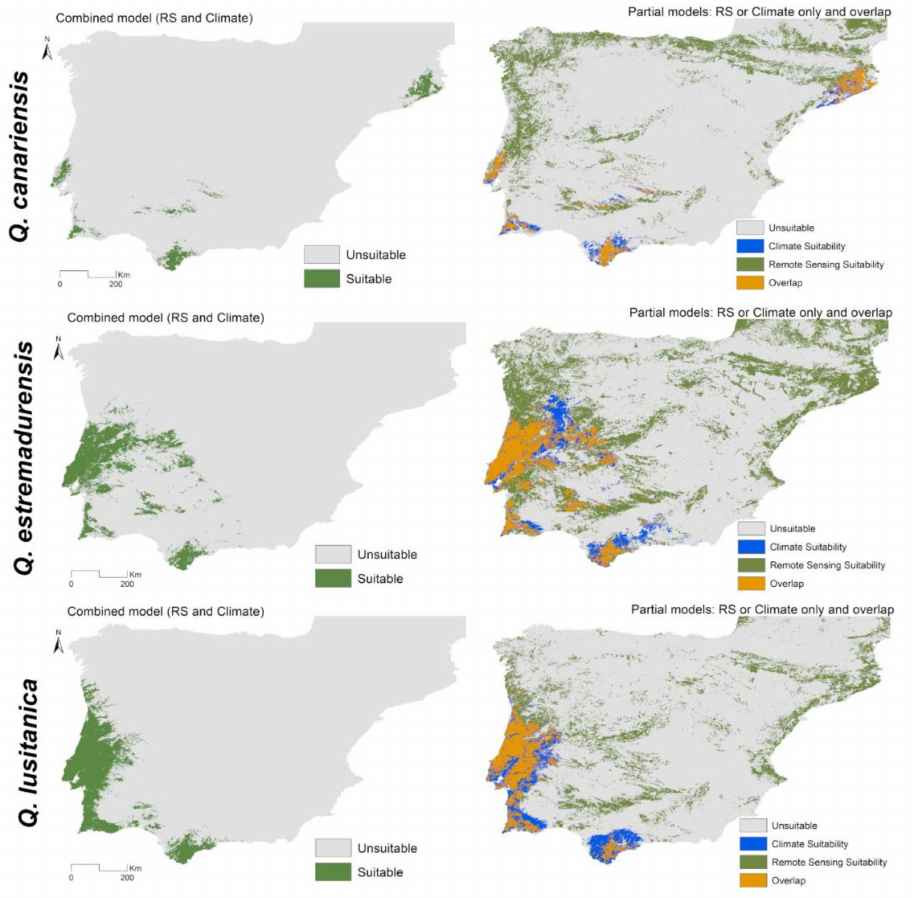
Figure 5. (Left) Combined models (remote sensing EFA—and climate) and (right) partial models (remote sensing EFA in green or climate in blue and their spatial overlap in orange) for narrow distributed White Oaks Q. canariensis , Q. estremadurensis and Q. lusitanica